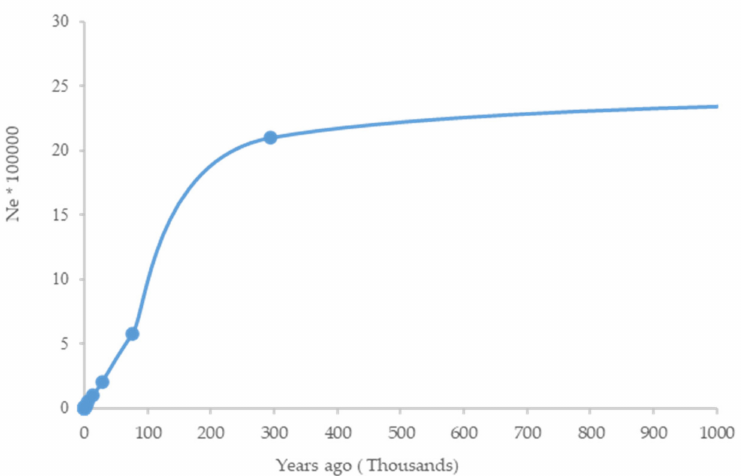
Figure 7. The historical demography of the dromedary camel was examined using